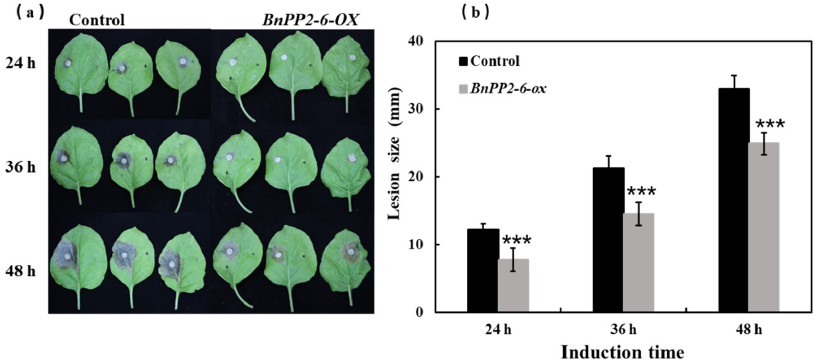
Figure 7. The functional validation of BnPP2-6 for SD resistance using transient expression in tobacco: ( a ) the disease lesion sizes on leaves at 24, 36 and 48 h post inoculation with S. sclerotiorum , transiently injected through agrobacterium containing BnPP2-6-ox recombinant vectors and empty vectors (negative control) into tobacco leaves; ( b ) the disease lesion sizes were analyzed statistically by comparing the overexpressed BnPP2-6 to the control. The data represent the means ± 2SDs from three independent experiments, each containing 20 leaves. Significant differences in lesion sizes between BnPP2-6- Ox and the control are indicated (Student’s t -test) as follows: *** p < 0.001.